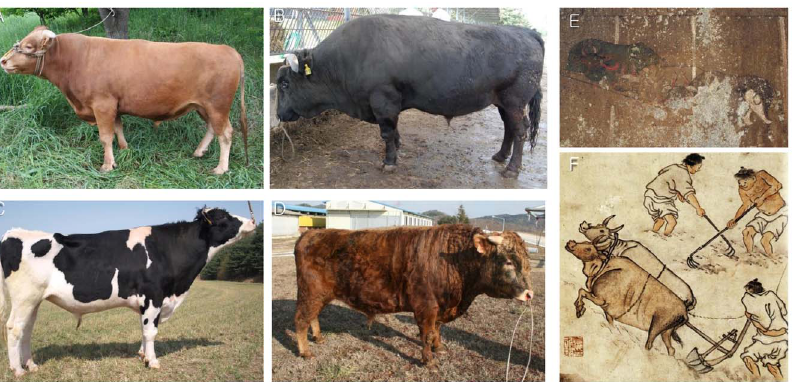
Figure 1. Korean cattle breeds used in this study. (A) Hanwoo. (B) Jeju Heugu. (C) Korean Holstein. (D) Chikso. (E) Mural painting in the Anak tomb no. 3 (A.D. 357) in the Goguryeo age: a stable illustrating three cattle in black, yellow, and brindle colors (courtesy of Dr. Ho-Tae Jeon). F: Eighteenth century painting by Hong-Do Kim (1745–1806), Joseon Dynasty, depicting farmers ploughing a rice field using Korean native cattle (at the National Museum of